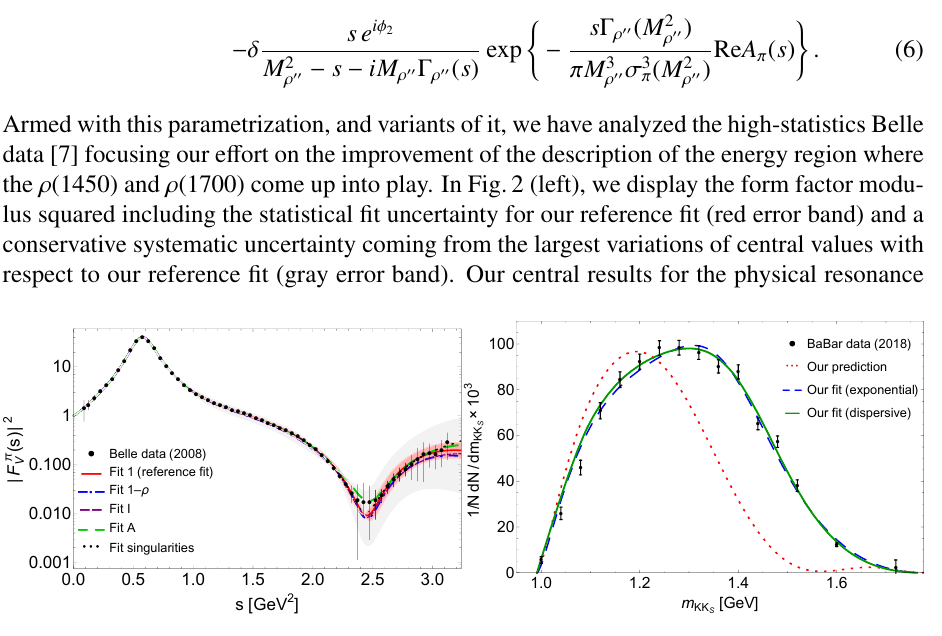
Figure 2. Belle measurement of the modulus squared of the pion vector form factor [7] (left) and BaBar data [8] for τ − → K − K S ν τ (right) as compared to our fits. See Ref.[1] for